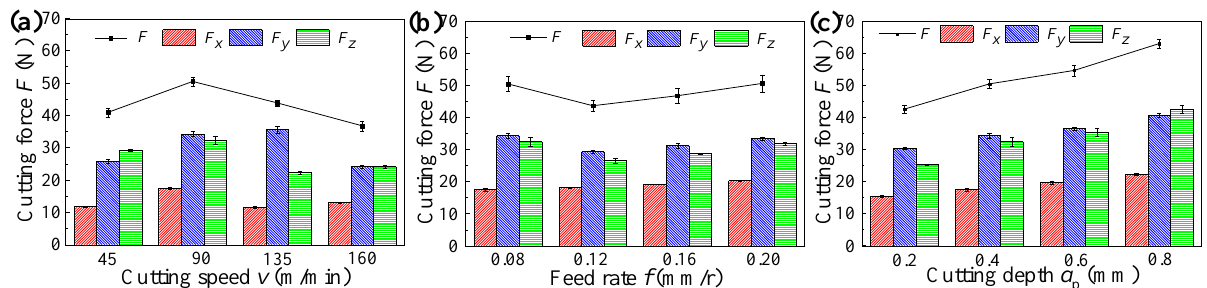
Figure 4. Cutting forces obtained under different cutting parameters: ( a ) cutting speed, ( b ) feed rate, and ( c ) cutting depth.